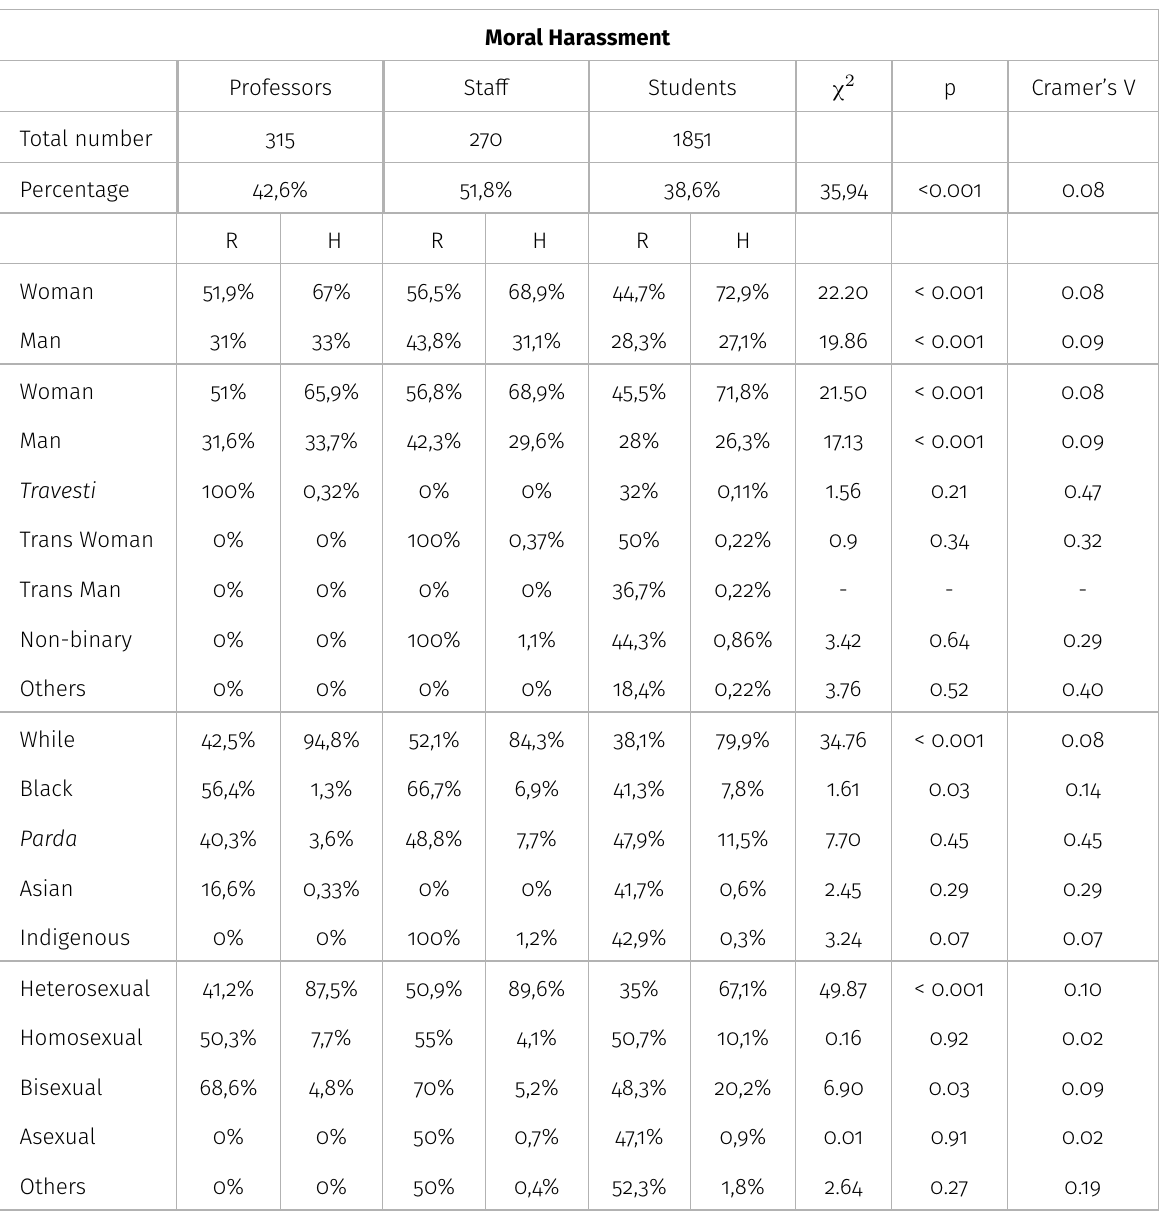
Table II. First line shows the total number of people who suffered moral harassment among respondents to the questionnaire and the second line shows the percentage in terms of the total number of professors, technical and administrative staff and students. From the third line, the percentages of people harassed are discriminated in terms of different categories, whose identification is shown in the first column. For each of group (professors, staff and students) there are two columns: the column identified as ”R”, which corresponds to the percentage of respondents who suffered harassment normalized by the universe of respondents in each category and the column ”H”, that is the percentage of harassed people in each category. The last three columns are χ 2 tests, p-values, and Cramer’s V for effect